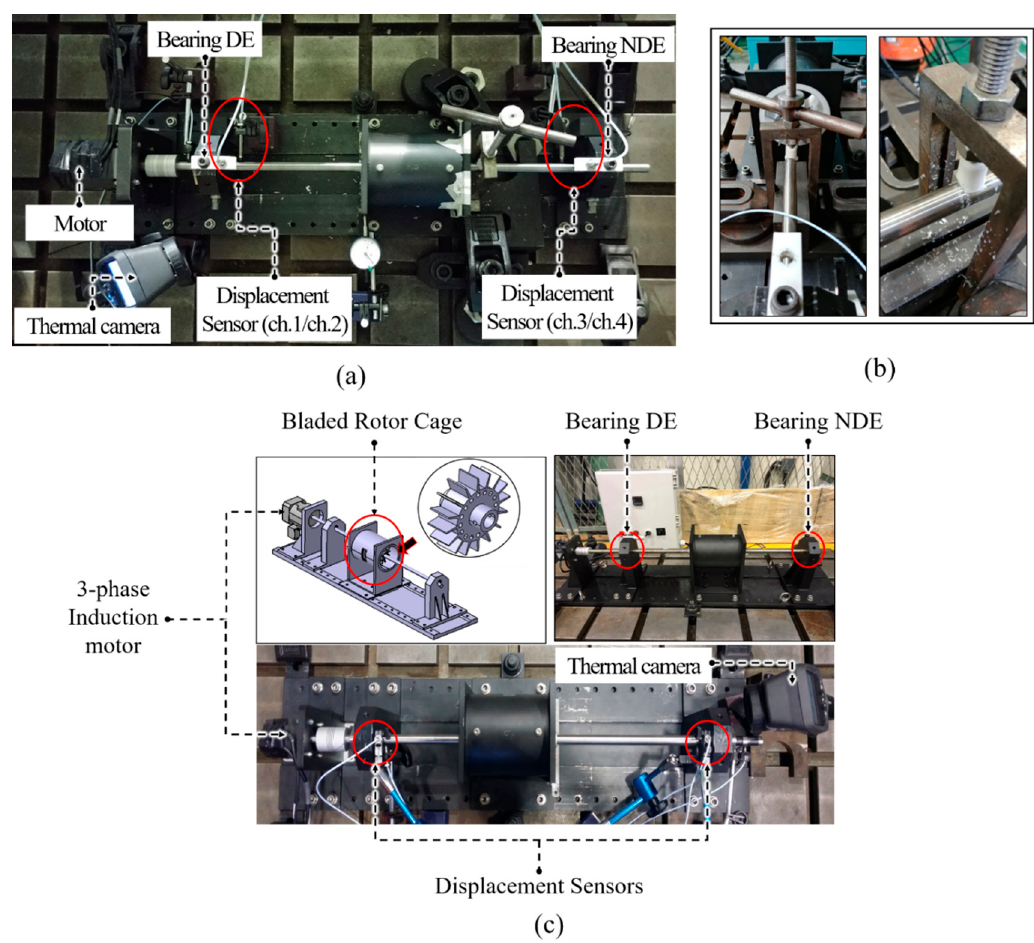
Figure 2. The self-designed test rig for rub-impact fault diagnosis: ( a ) the overall view of the testbed; ( b ) the device used to create shaft imbalance; and ( c ) simplified component view. DE, drive end; NDE, non-drive end.